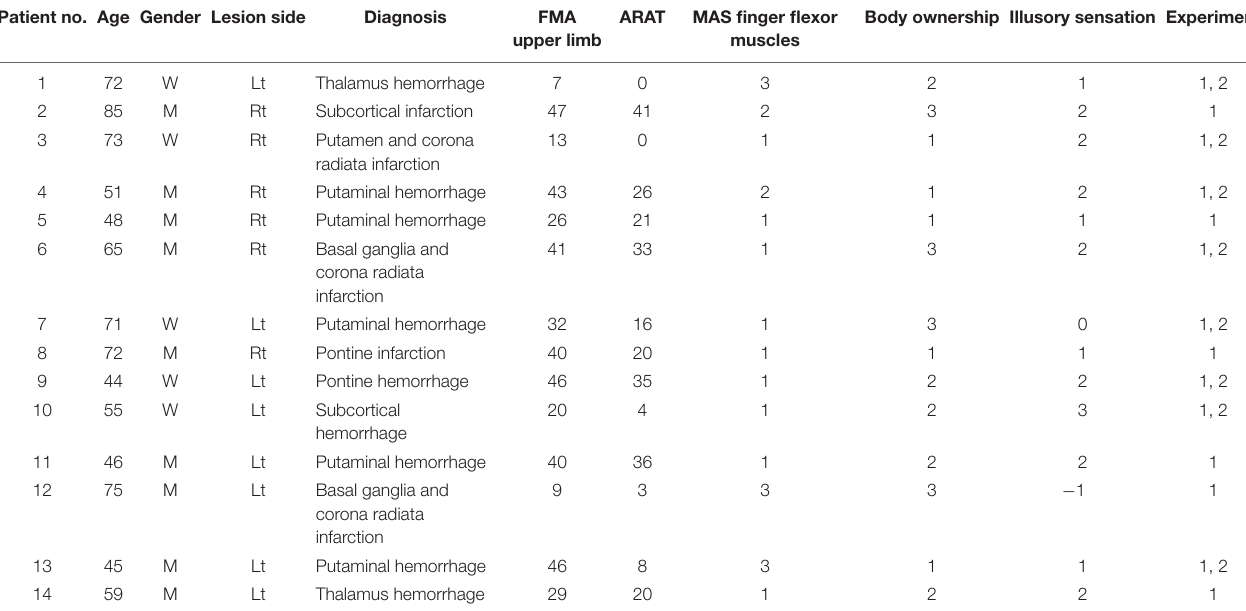
TABLE 1 | Patient